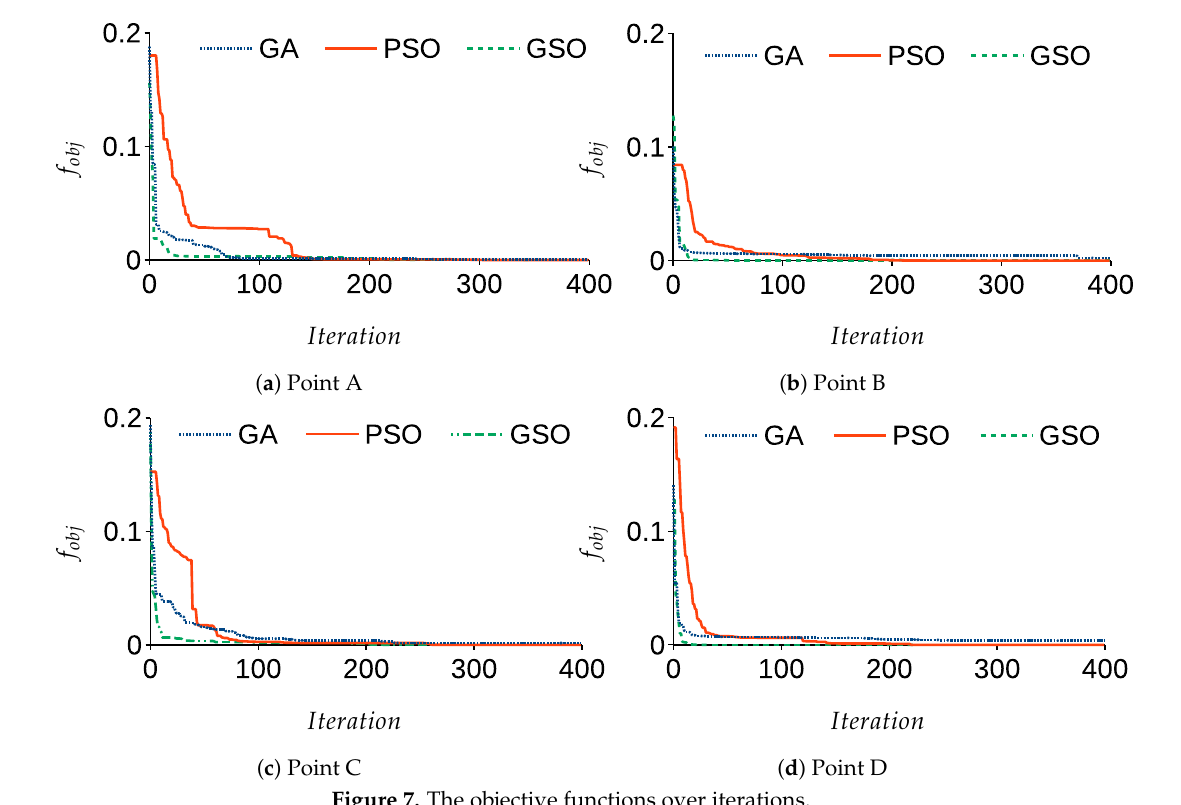
Figure 7. The objective functions over iterations. Table 6. PID parameters tuned by PSO.